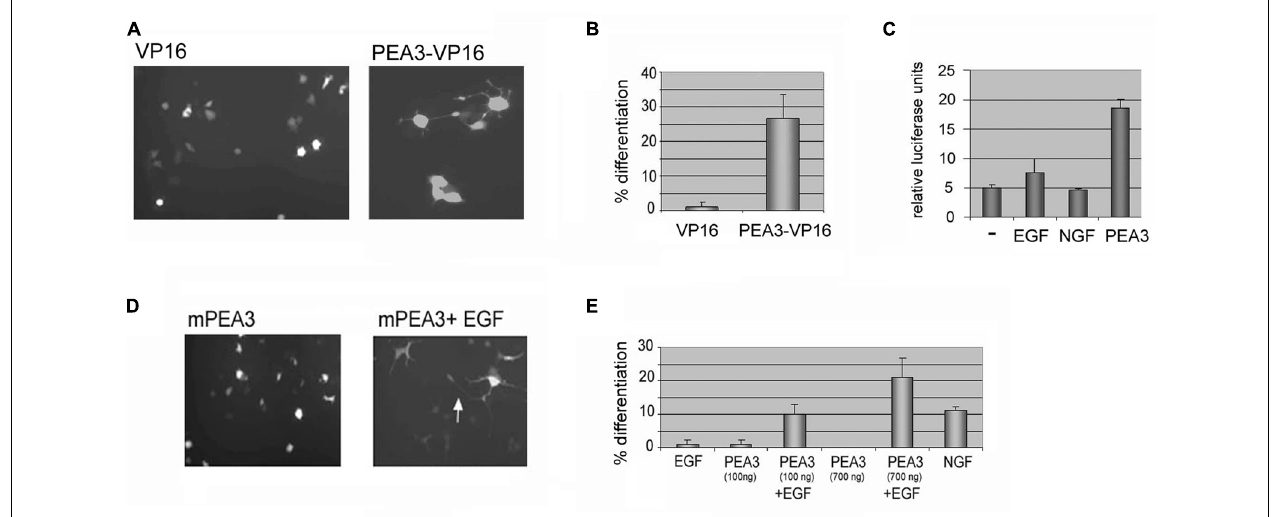
construct; average of at least three independent experiments. (D) A typical micrograph of cells transfected with 500–1 μ g of GFP expressing plasmid in 1:3 ratio with either a control plasmid expressing pCDNA3 (not shown), pCDNA3 Pea3, or pCDNA3 Pea3 in combination with EGF as described, and analyzed by fluorescence microscopy. The arrow shows axon-like processes several cell body length. (E) A graph summarizing the scoring for differentiation experiment in (D) . The experiment was repeated with two different DNA preparations for pCDNA3 Pea3, and at least 3 fields per well were counted. The control plasmid pCDNA3 yielded no differentiation (not shown), while NGF in a similar time scale (2–4 days after transfection) resulted in around 12% differentiation (not